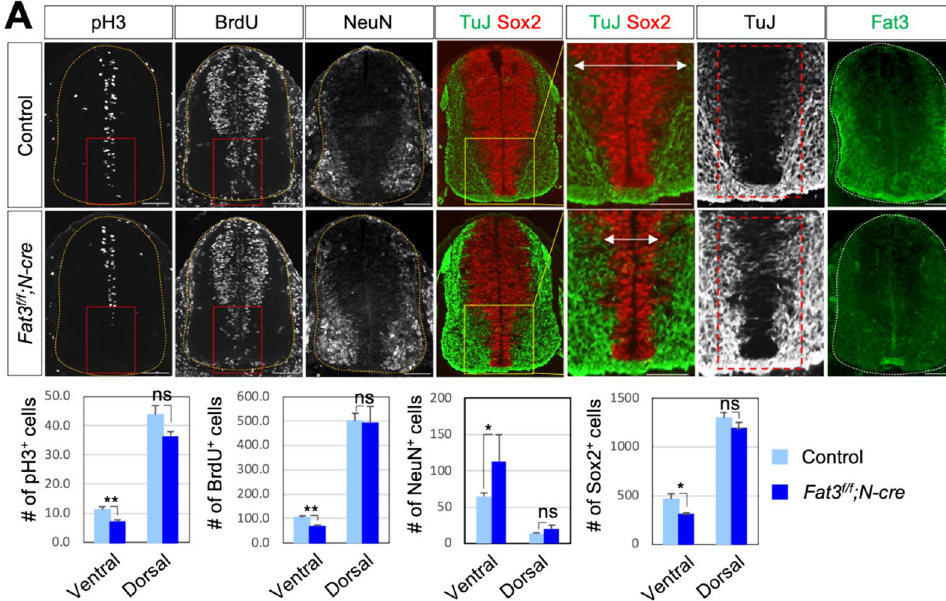
Figure 3. Fat3 is crucial for proper ventral progenitor formation in developing mouse spinal cord. ( A ) The expression of proliferation markers (pH3, BrdU, Sox2) and neuronal markers (NeuN and TuJ) in transverse sections at E11.5 in Fat3 f/f ;N-Cre embryos (n = 3) and their littermate controls (n = 4) by immunostaining analyses with indicated antibodies for mouse embryos (cervical level). IHC with anti-Fat3 antibody confirms the absence of Fat3 expression in Fat3 f/f ;N-Cre embryos. Quantification was performed with 5–10 images from multiple embryos as indicated and at least three sections from each embryo. Values are means ± sem. *p < 0.05, **p < 0.01 (Student’s t-test); ns not significant. Dotted outlines indicate the border of the spinal cord. Scale bars: 100